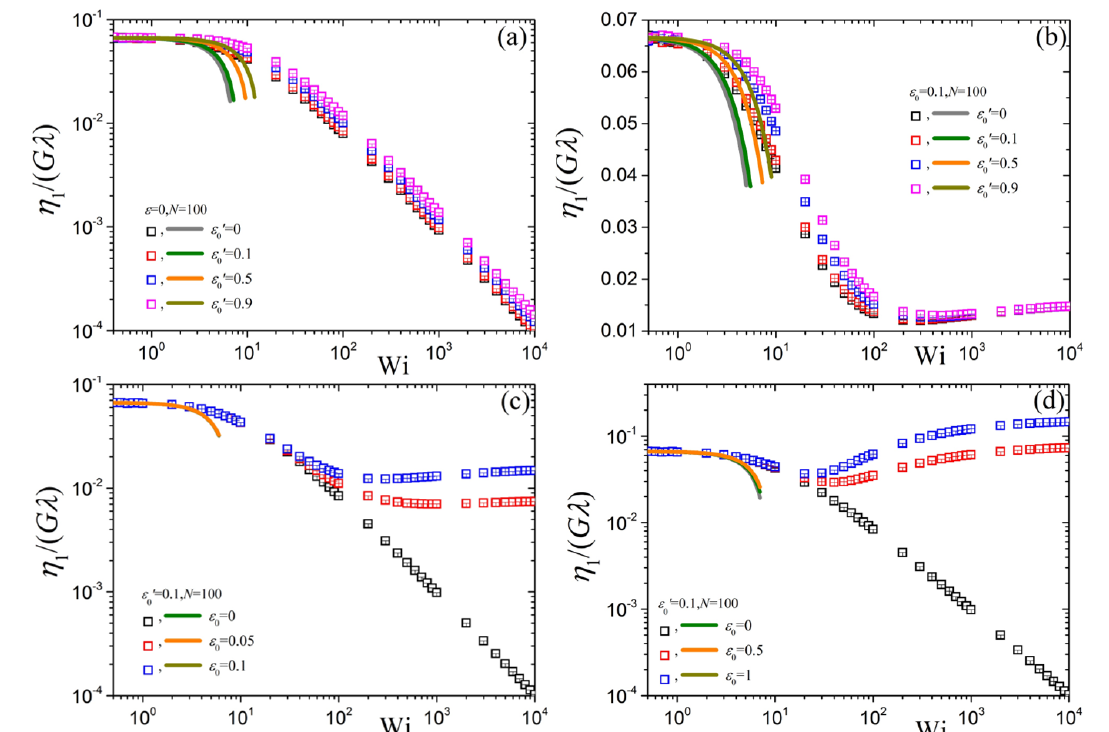
Figure 4. Predictions for η 1 ( ˙ (cid:101) ) / G λ for the tumbling snake model with variable ε as a function of dimensionless elongation rate Wi for N = 100 and various values of the parameters ε 0 and ε (cid:48) . ( a ) ε 0 = 0, 0 = 0.1, various ε various ε (cid:48) , ( b ) ε 0 = 0.1, various ε (cid:48) , ( c , d ) ε (cid:48) 0 . The solid lines mark the predictions of the 0 0 0 = 0. At large rates the viscosity small rate expansion, Equation (24), or Equation (25) for the case of ε (cid:48) 0 approaches the value given by Equation